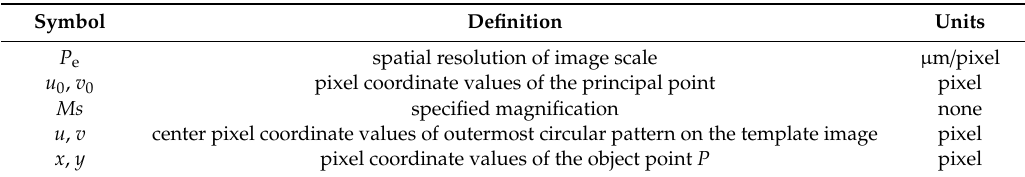
Table 2. Definition of some